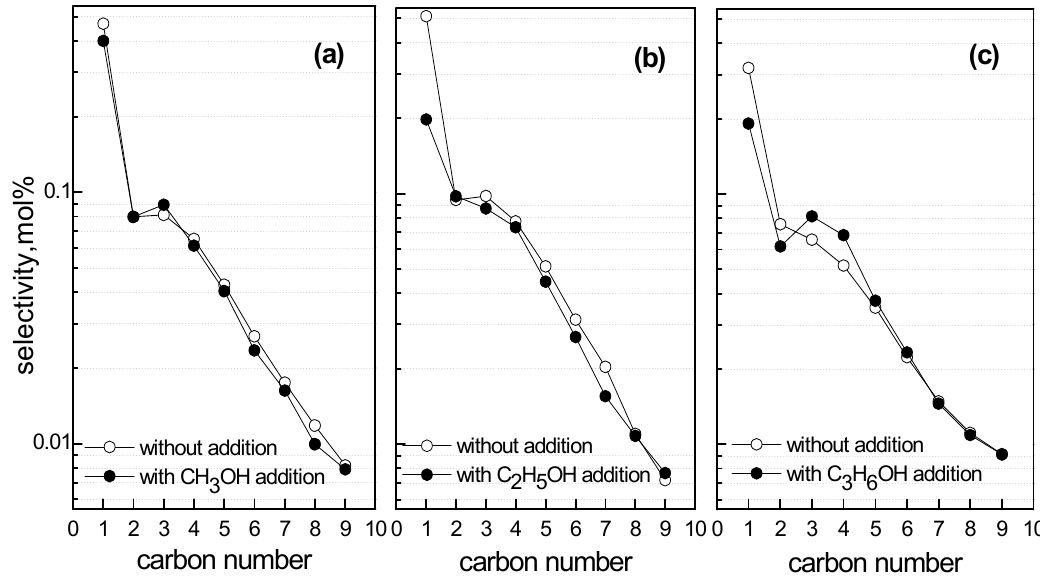
Figure 8. The effect of C 1 -C 3 alcohol addition on the total hydrocarbon distribution in the FTS process. Reaction condition: T = 533 K, p = 0.8 Mpa, H 2 /CO = 8, and ( a – c ) with CH 3 OH = 0.5 mL/h, C 2 H 5 OH = 0.7 mL/h and C 3 H 7 OH = 1.0 mL/h, respectively.